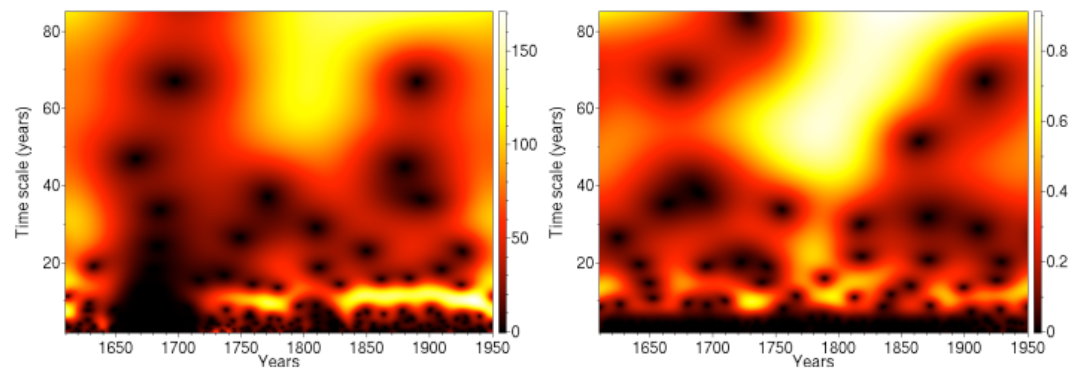
Fig. 4. Scalogram of the group sunspot number (to the left) and of the 14 C production rate (to the right).